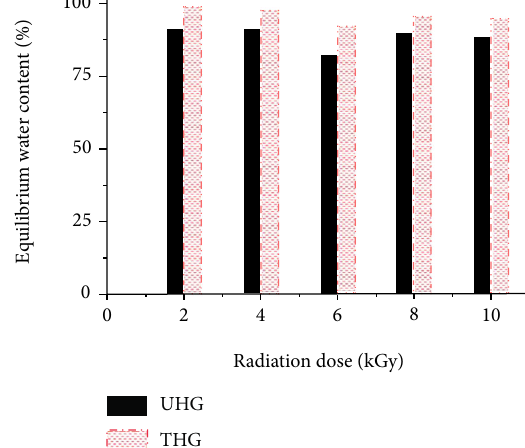
Figure 5: The equilibrium water content of THG and UHG with radiation dose.